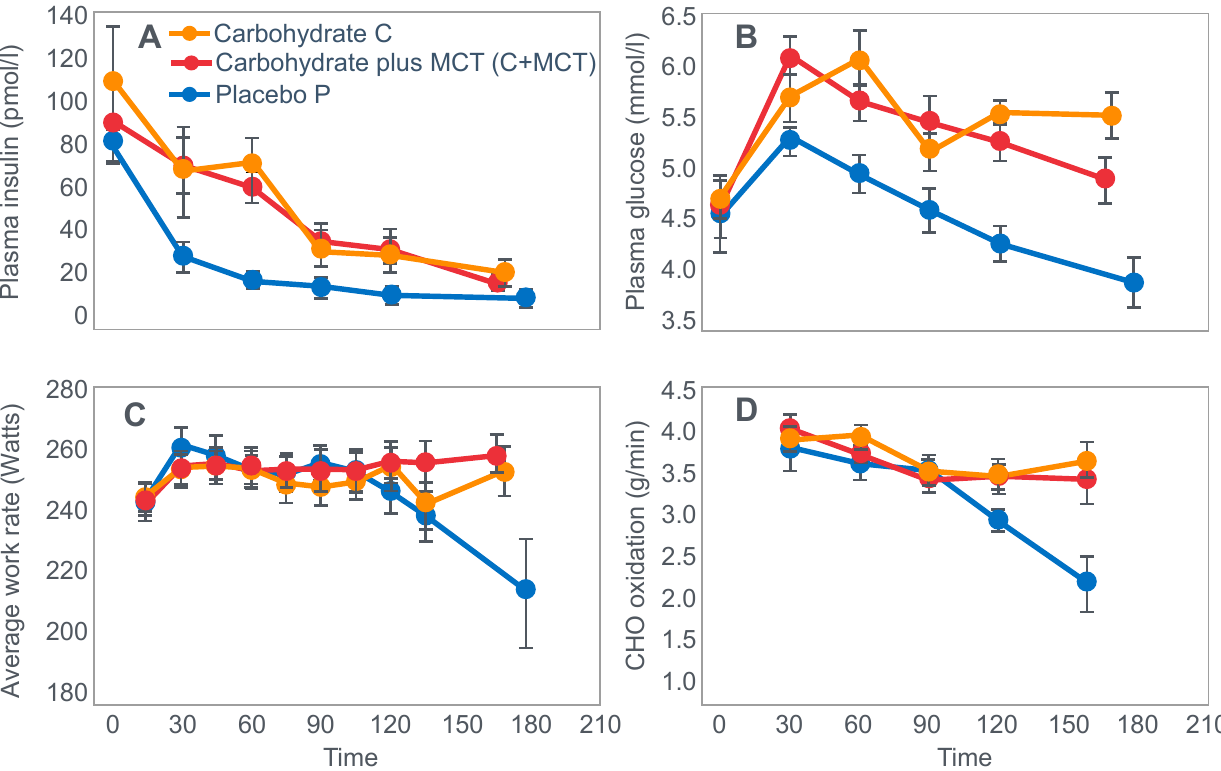
Figure 24. Changes in plasma insulin (panel A ) and plasma glucose (panel B ) concentrations; average work rate (panel C ) and rates of carbohydrate oxidation (panel D ) when subjects ingested either carbohydrate (C), carbohydrate plus medium chain triglycerides (C + MCT) or a sweetened placebo (P) during a 100 km cycling time trial in the laboratory. Note: In the original diagrams, it is not possible in some panels to distinguish between lines drawn for the C and C + M groups as the lines appear to be incorrectly labelled. However, the lines are largely overlapping. Adapted with permission from ref. [69]. Copy-right 2000 American Physiological Society.